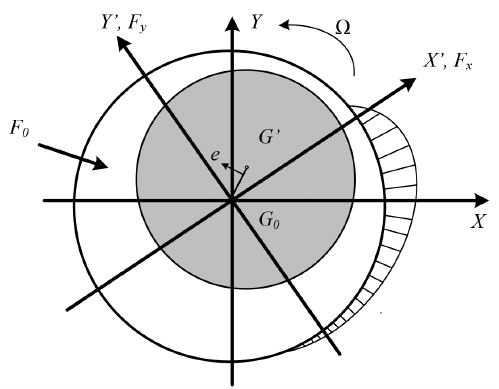
Figure 3. Hydrodynamic